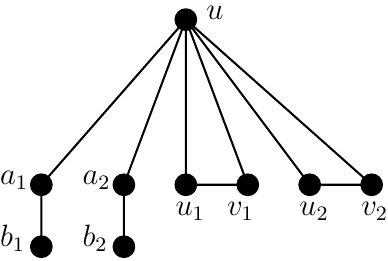
Figure 3. { u 1 , u 2 } is a plenty twin set but it is not a determining